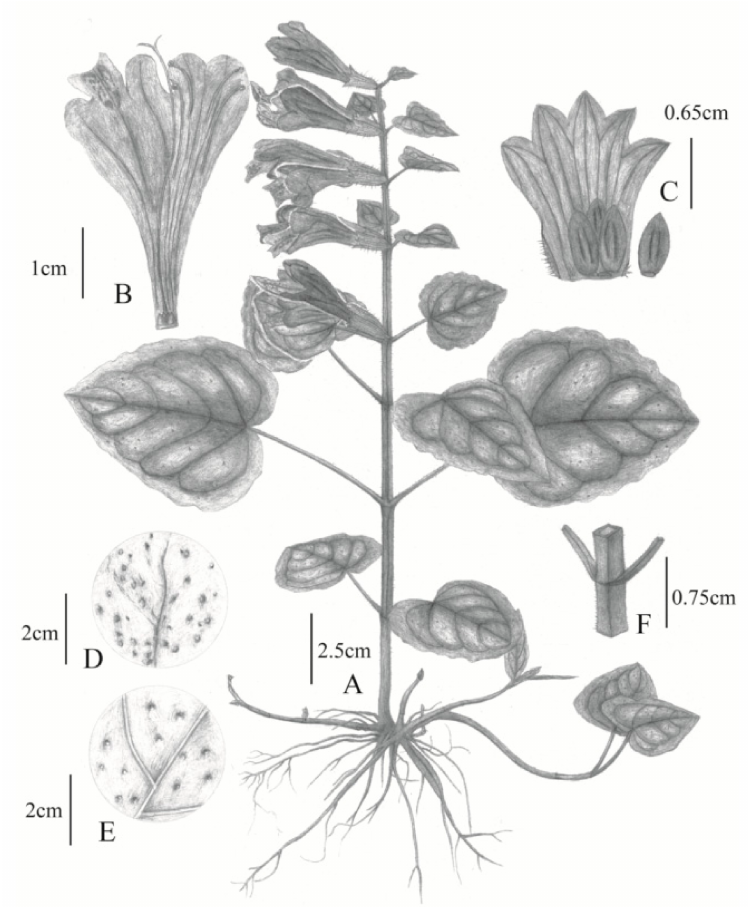
Figure 6. Illustration of Meehania zheminensis A. Takano, Pan Li and G.-H.Xia; ( A ) plant with inflorescence; ( B ) corolla dissected; ( C ) calyx dissected, with four seeds; ( D ) adaxial surface of leaves; ( E ) abaxial surface of leaves; ( F ) stem node. Drawn by Xinjie